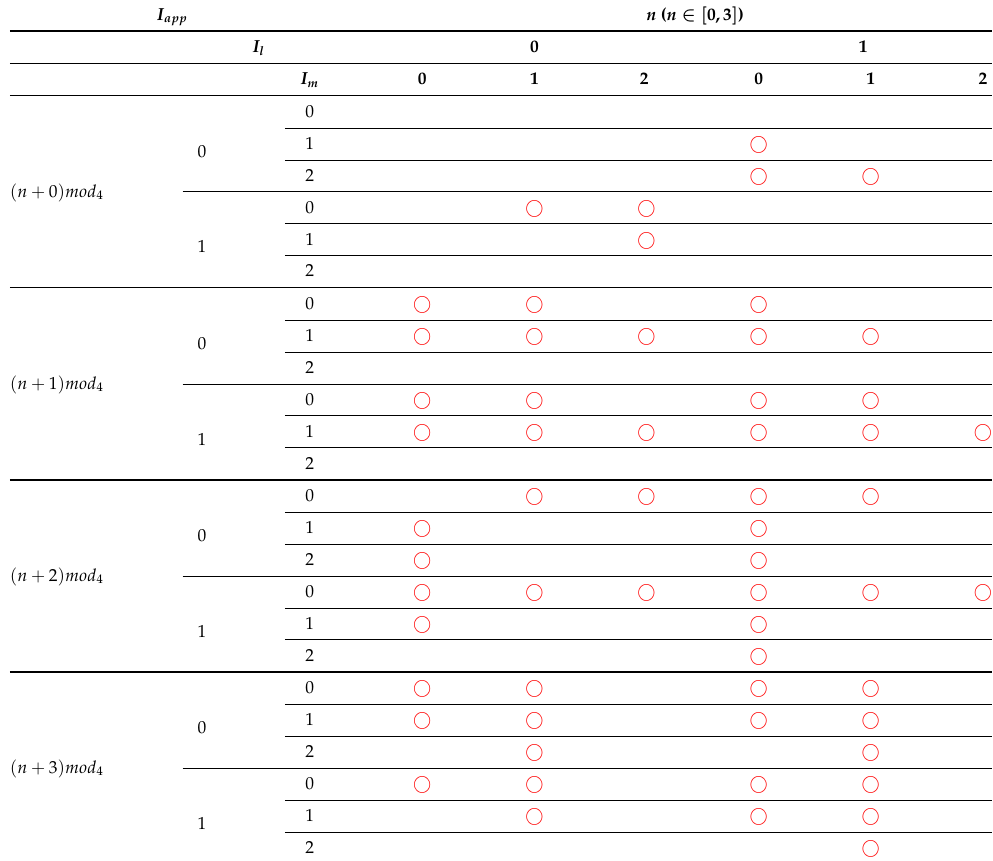
Figure 2. Conflict points among the trajectories. Table 2. Conflict points among all the